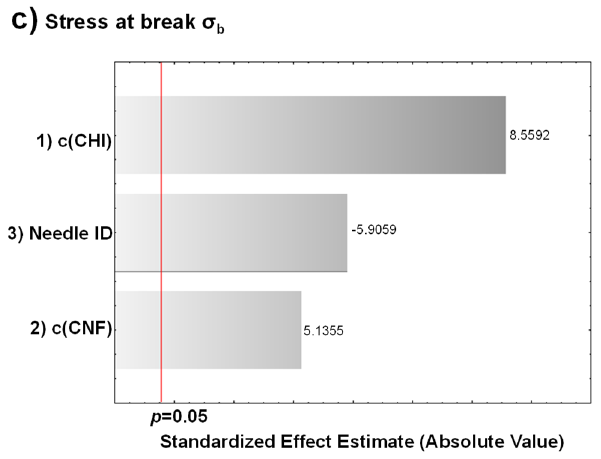
Figure 7. Pareto chart of the three responses: ( a ) hydrogel filament diameter, ( b ) Young’s modulus E, and ( c ) stress at break σ b , after considering a two level variation of the variables: (1) c(CHI), (2) c(CNF), and (3) needle ID, in a 2 3 factorial experimental design.